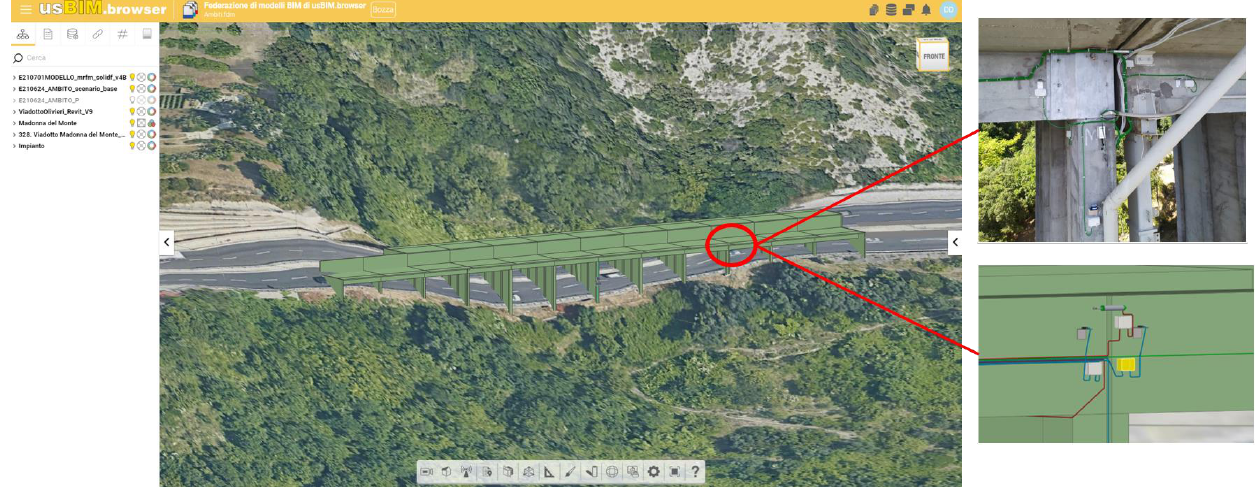
Figure 7. BMS platform. Figure 8 describes an example of a BIM model hierarchy.